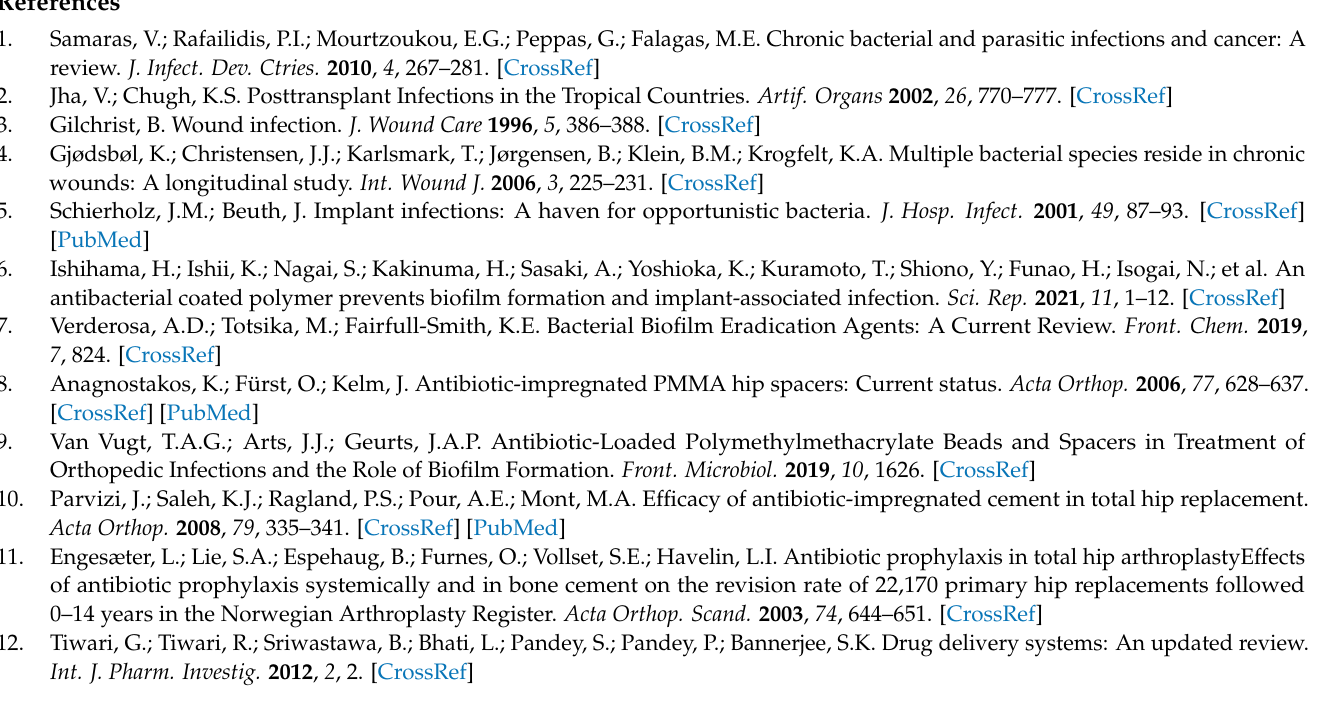
Figure S2: The overall prolonged release profile of ceftriaxone from microchamber arrays prepared at various concentrations of PLA in a patterned film (a) PLA 1%, (b) PLA 1.5%, (c) PLA 2% and (d) PLA 2.5%; Figure S3: Image of plates with samples: inhibition of bacterial growth with daily samples transferred to new plates during 5 days; Figure S4: Image of plates with samples after ultrasound exposure; without ultrasound exposure: inhibition of bacterial